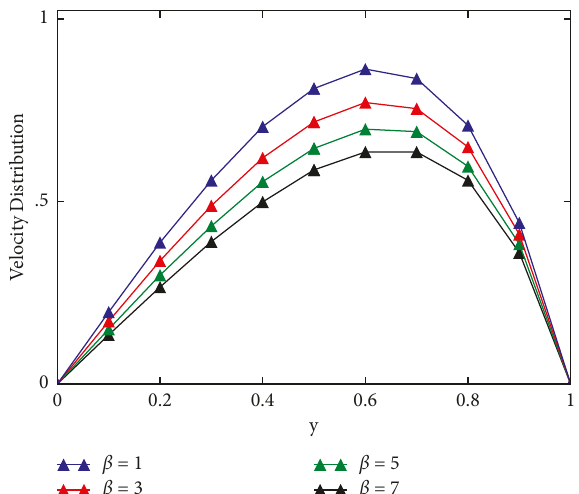
Figure 14: The velocity effect of the BT fluid beta , Pr